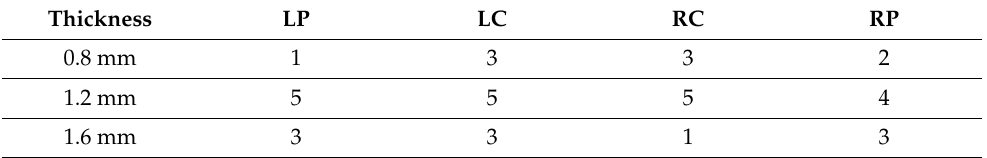
Table 1. Clicker grain distribution according to the thickness of the root canal wall (0.8, 1.2, 1.6 mm) and location within a sample (LP–left peripheral, LC–left center, RC–right center, RP–right peripheral).